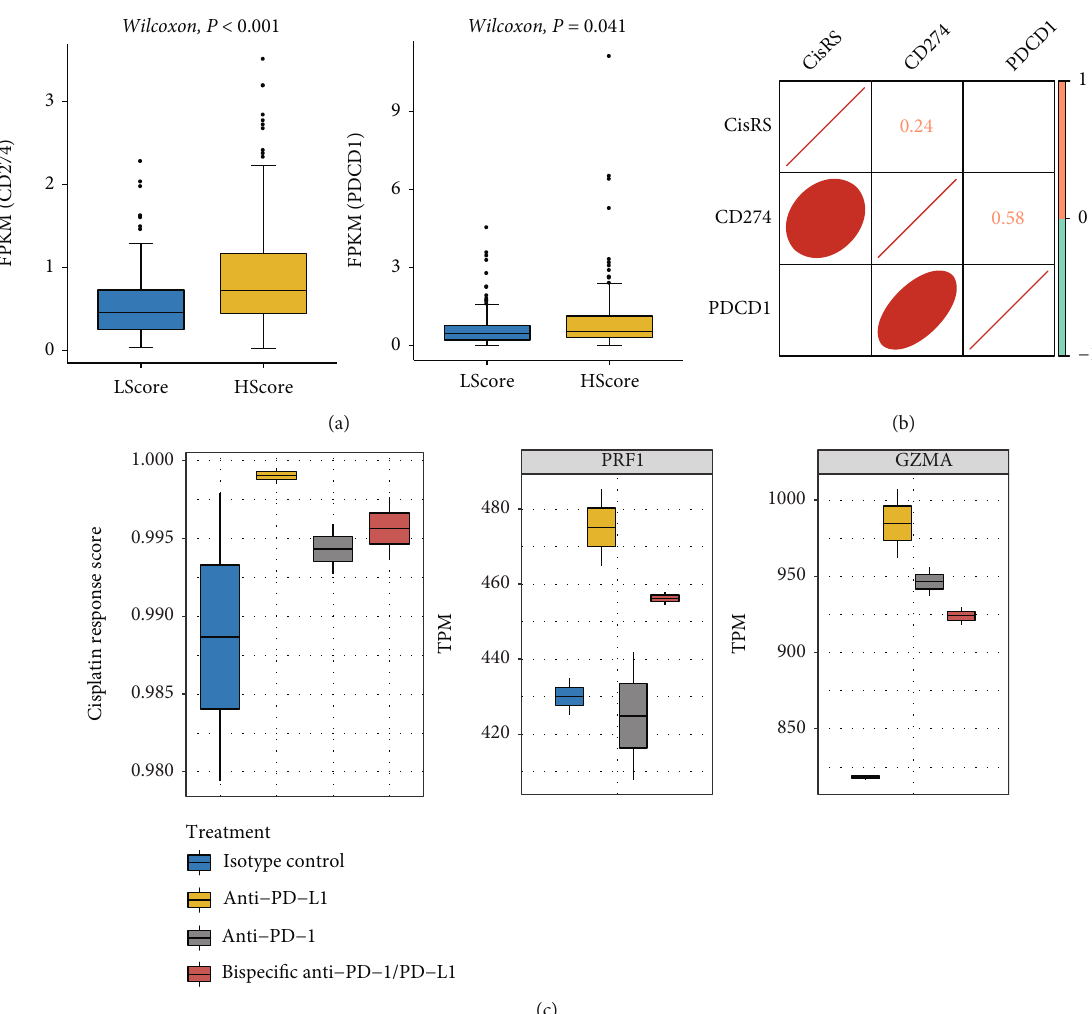
Figure 6: The association of cisplatin response scores with immunotherapy. (a) The expression values of CD274 and PDCD1 in high-score (HScore) and low-score (LScore) groups. FPKM: fragments per kilobase per million. (b) The correlation matrix showed the correlations between cisplatin response scores (CisRS) and CD274 and PDCD1. (c) The cisplatin response scores and expression values of PRF1 and GZMA between the four groups, isotype control, anti-PD-L1 treated, anti-PD-1 treated, and bispeci fi c anti-PD-1/PD-L1 treated. TPM: transcripts per